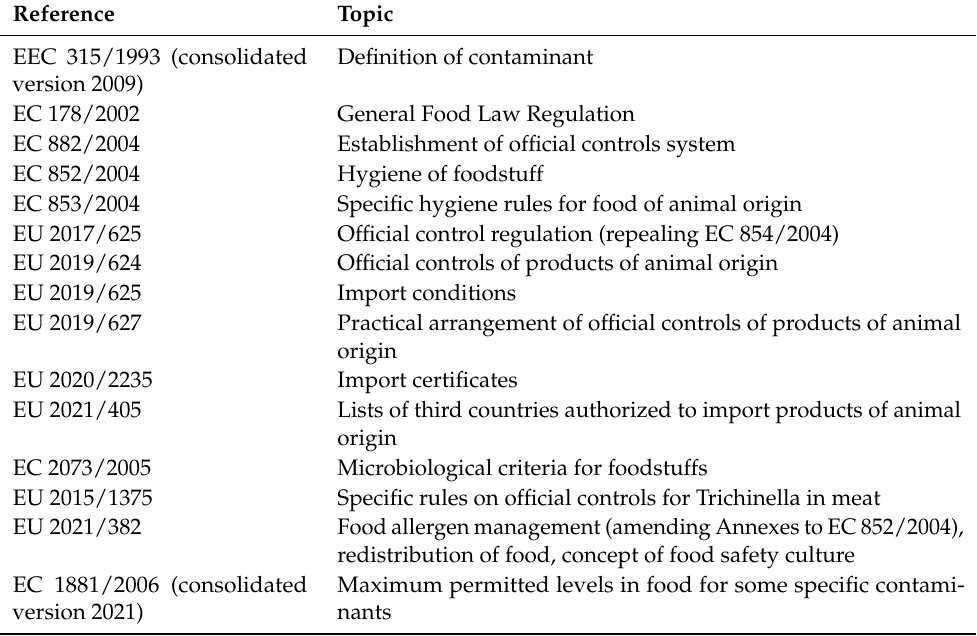
Table 1. List of some regulations and recommendations relevant for the food